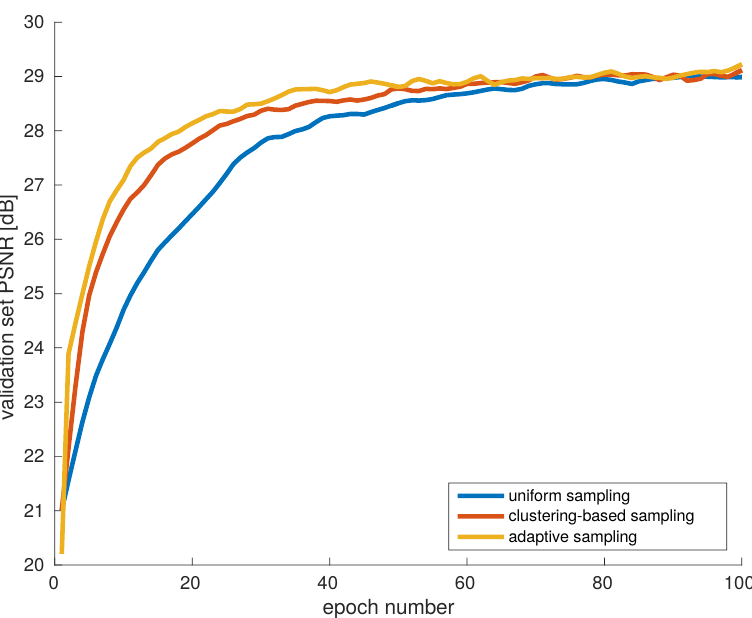
Figure 11. Evaluation of the two proposed strategies (clustering-based and adaptive sampling) against a uniform random sampling baseline. The proposed strategies clearly improve the training